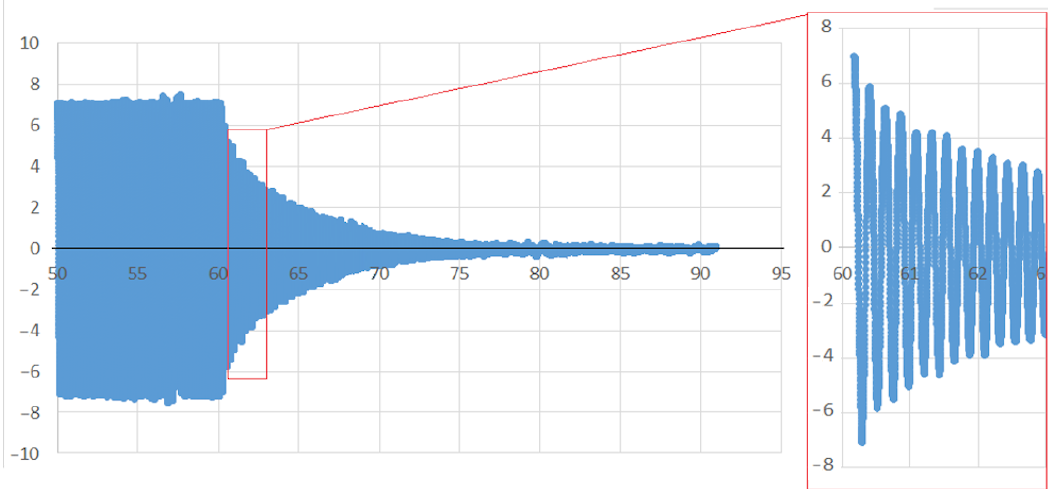
Figure 13. Variations in the frequency of the free oscillations that occurred after subjecting the frame to the forced sinusoidal movement and during the structure’s free oscillations.